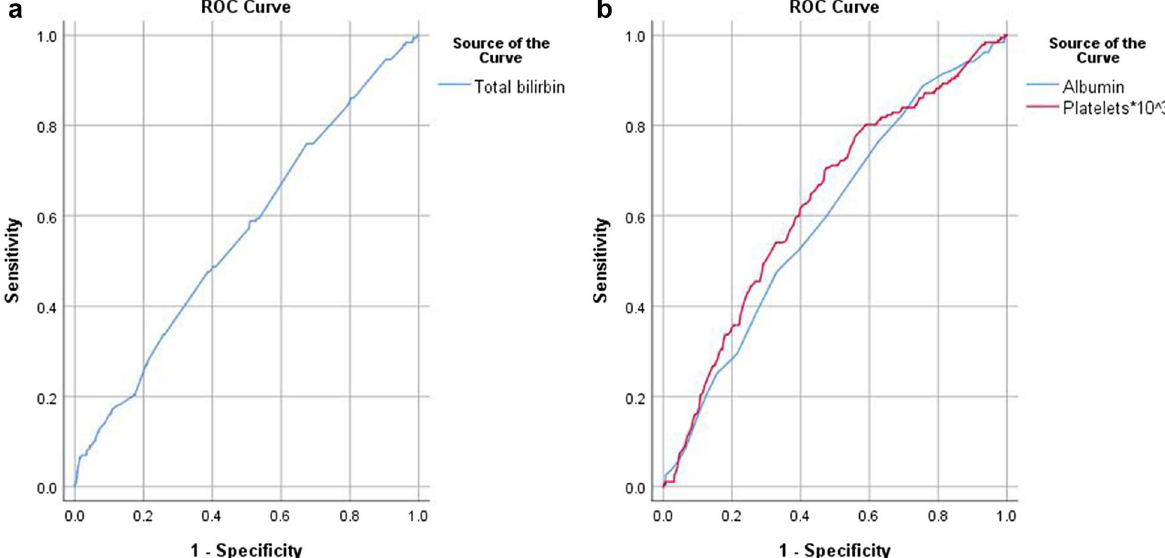
Fig. 1 ROC curve for prediction of hepatic decompensation after DAA therapy. a ROC curve for the prediction of hepatic decompensation after DAA therapy using total bilirubin. b ROC curve for the prediction of hepatic decompensation after DAA therapy using serum albumin and